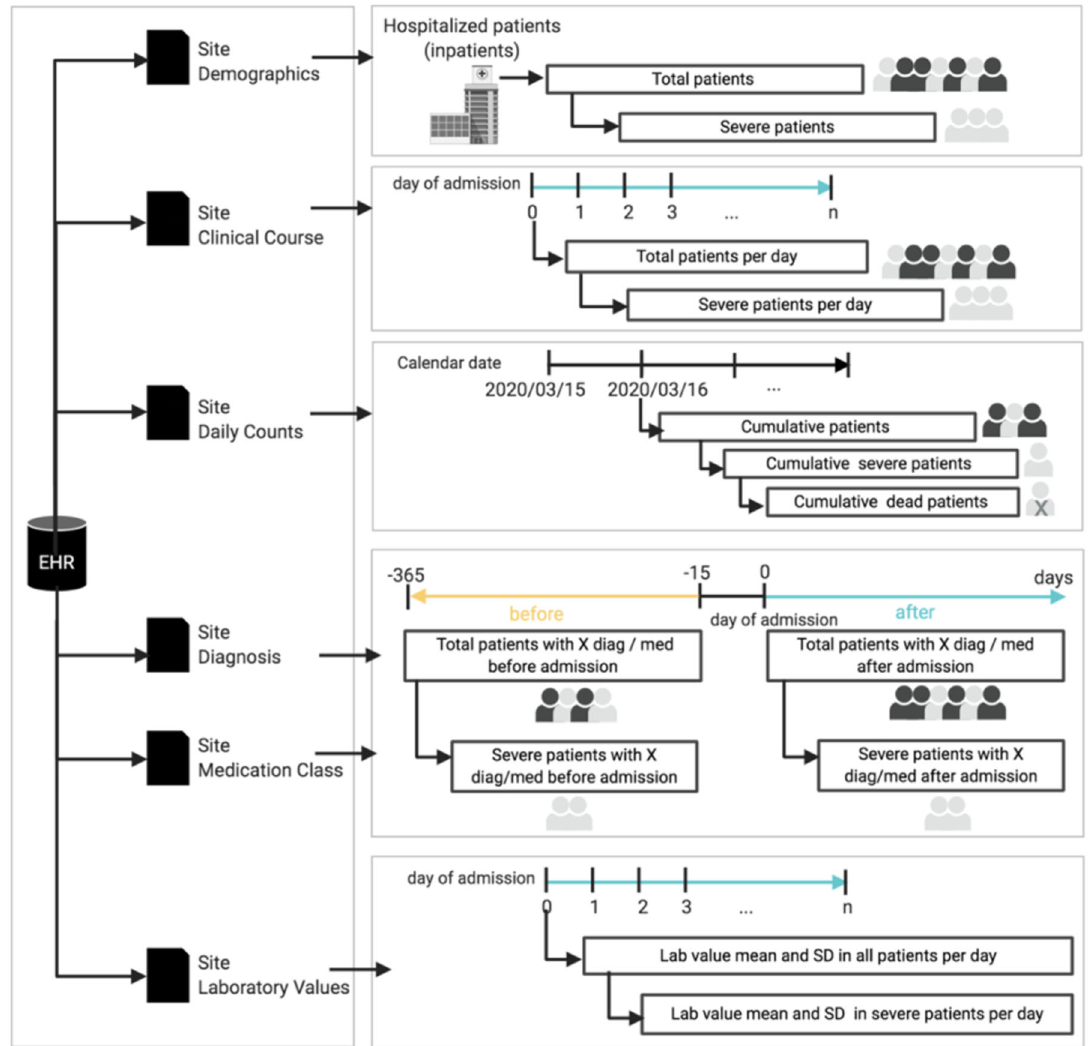
Fig. 4 Schematic of the federated EHR-based study involving healthcare systems from three countries. Each site generated three data tables (comma-separated fi les) containing patient level data: 1) local patient clinical course indicates which days the patient was in the hospital and when the patient died; 2) local patient observation includes fi rst three-character ICD9/10 diagnosis code and laboratory tests, where laboratory test has a numerical value; 3) local patient summary contains demographic variables including age, sex and race. Sites then conduct analysis using these individual level data within their fi rewall (see